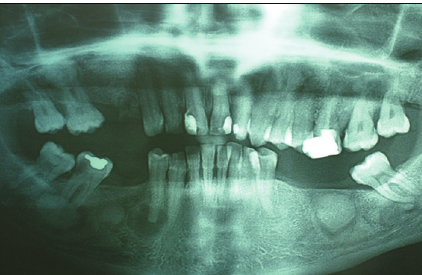
Figure 1: The first orthopantomography revealed the presence of three well-circumscribed, round, unilocular neoformations of radiopaque appearance with a radiotransparent edge, one of which was in close contact with the roots of the lower right second molar.